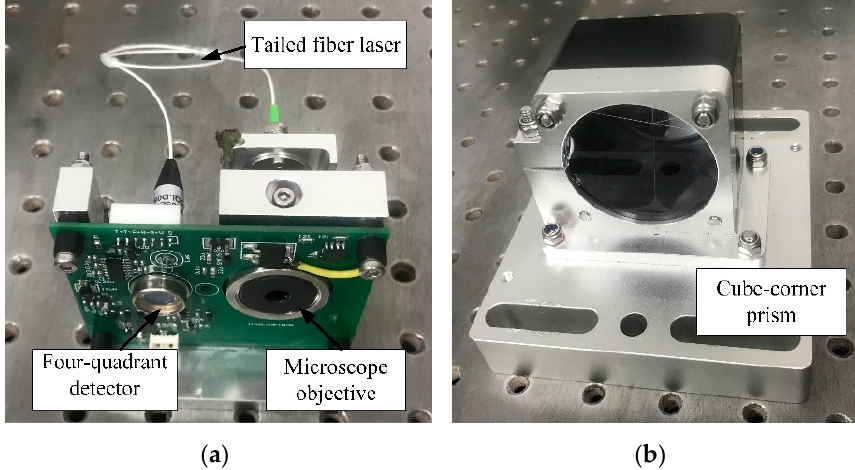
Figure 1. The picture of the sensor: ( a ) The light source and detection module; ( b ) The reflection module.